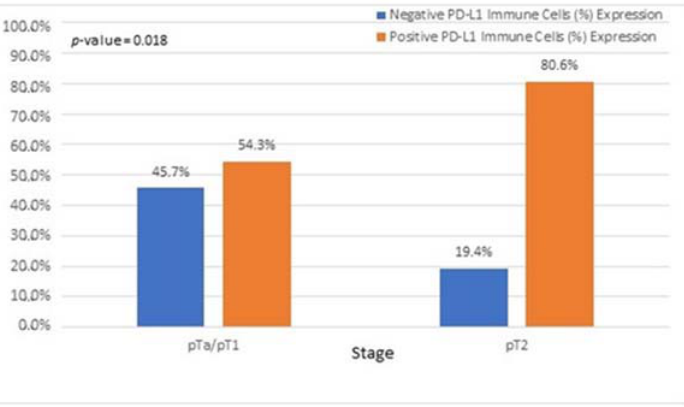
Figure 8. Associations of IC and TPS PD-L1 scores with bladder cancer molecular subtypes.